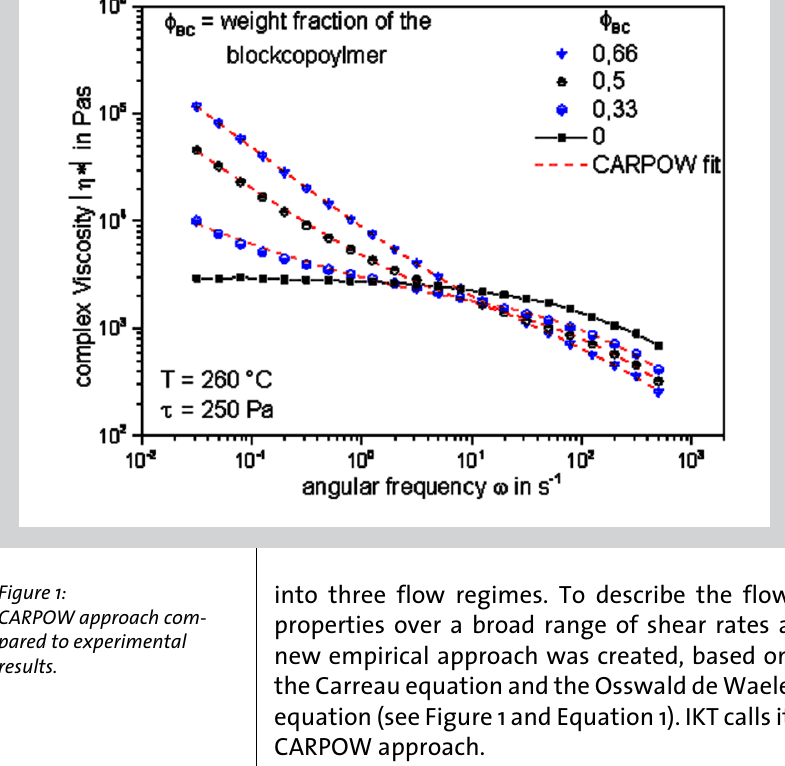
Figure 1: CARPOW approach com- pared to experimental